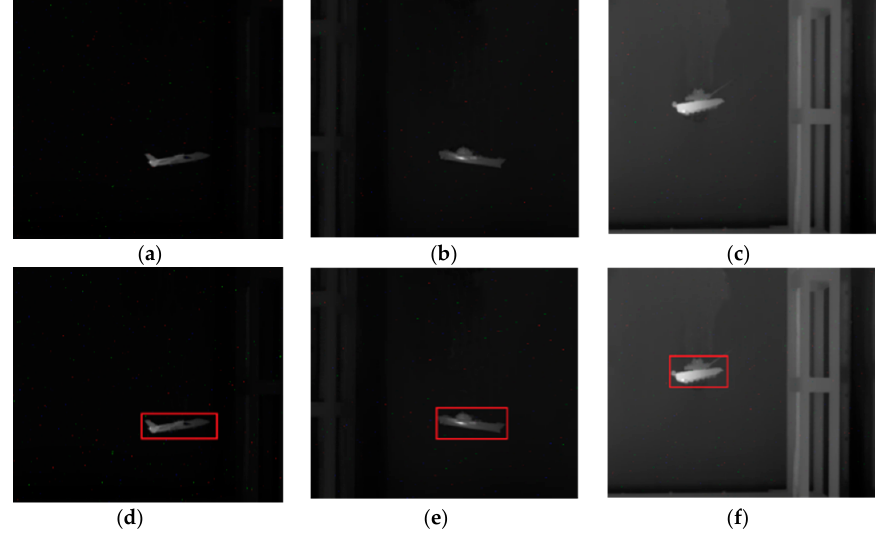
Figure 10. Images corrupted with the salt–pepper noises and initial contours in the experiment. ( a ) “planeN”; ( b ) “shipN”; ( c ) “tankN”; ( d ) Initial contour of “planeN” (size: 160 × 72); ( e ) Initial contour of “shipN” (size: 155 × 85); ( f ) Initial contour of “tankN” (size: 120 × 95).